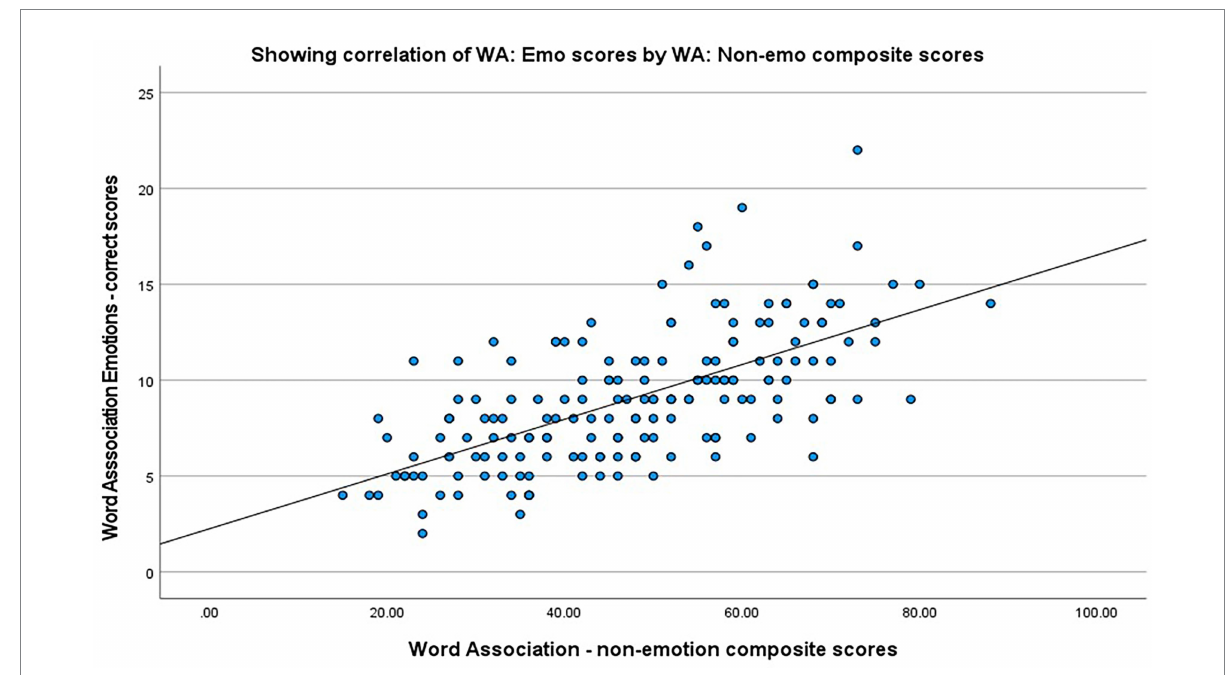
FIGURE 6 Scatterplot showing the correlation between WA:Emo and WA basic language composite